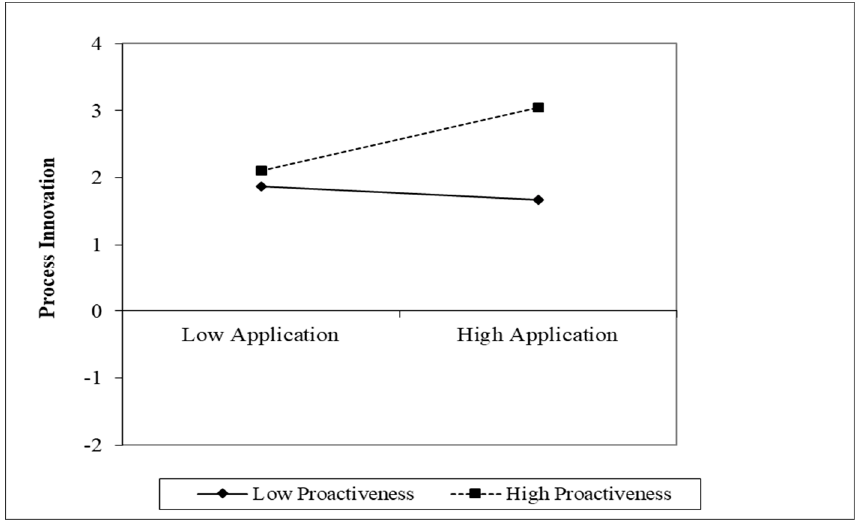
Figure 2. The moderating effect of proactiveness on the knowledge creation–process innovation relationship. Source: Own elaboration.